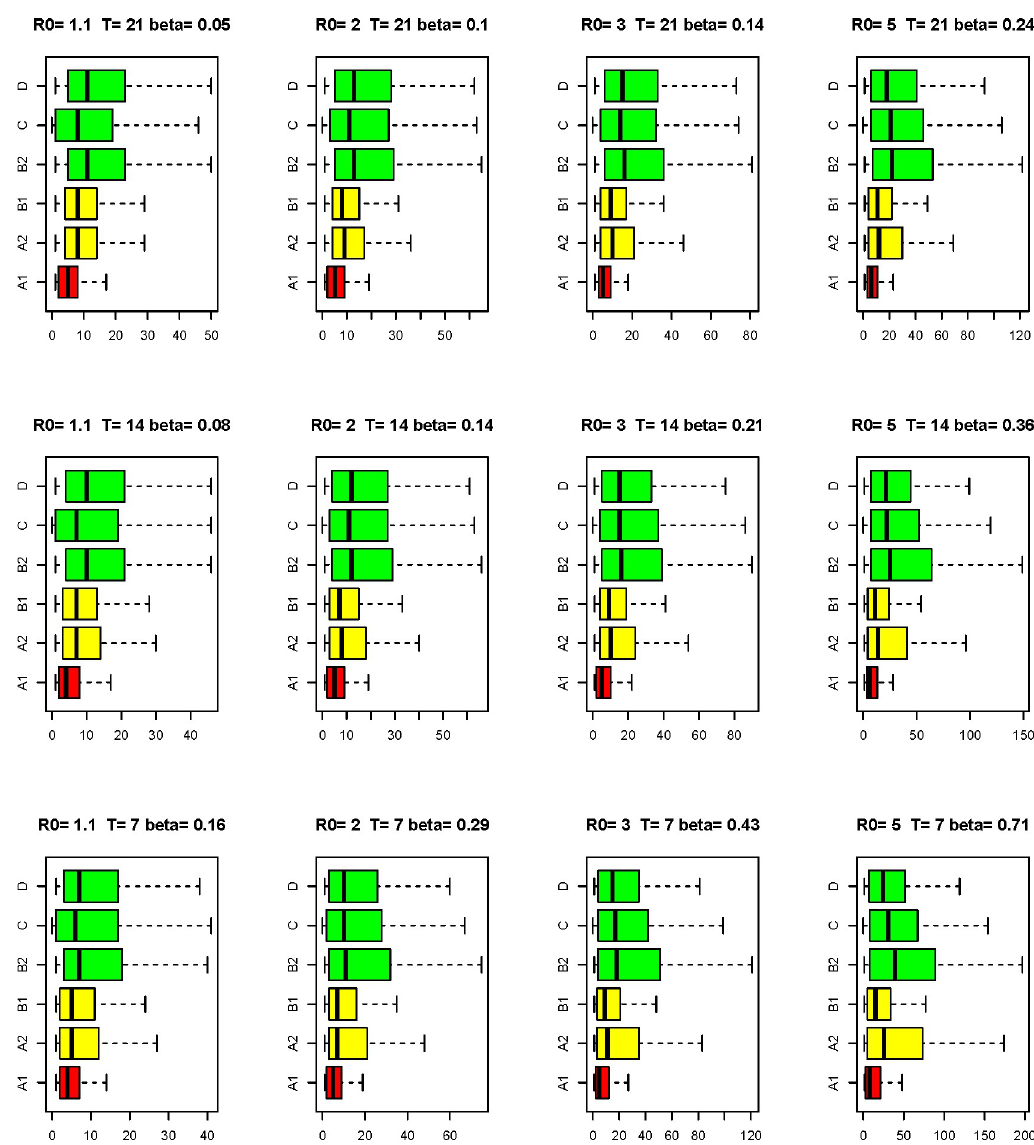
Fig 3. Boxplots of the lost infection-days by screening plan (A1, A2, B1, B2, C, D), under different epidemic scenarios, assuming that individual tests have sensitivity 0.7 and maximum specificity. In green the less expensive plans, in yellow the medium and in red the most